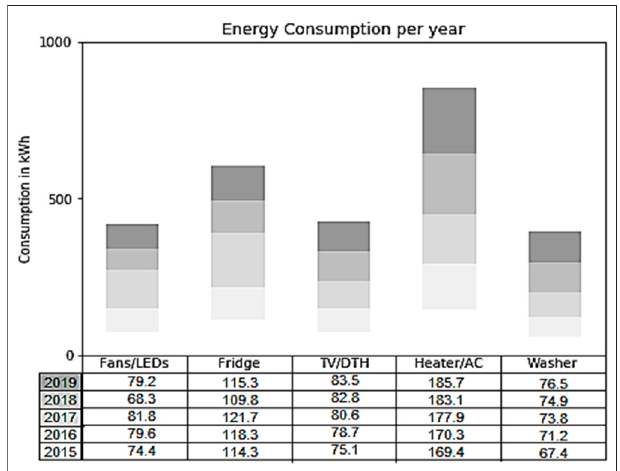
FIGURE 1 | Energy